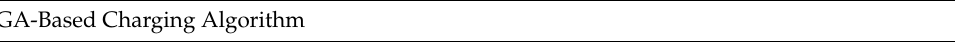
Algorithm 3 GA-based charging algorithm. GA-Based Charging